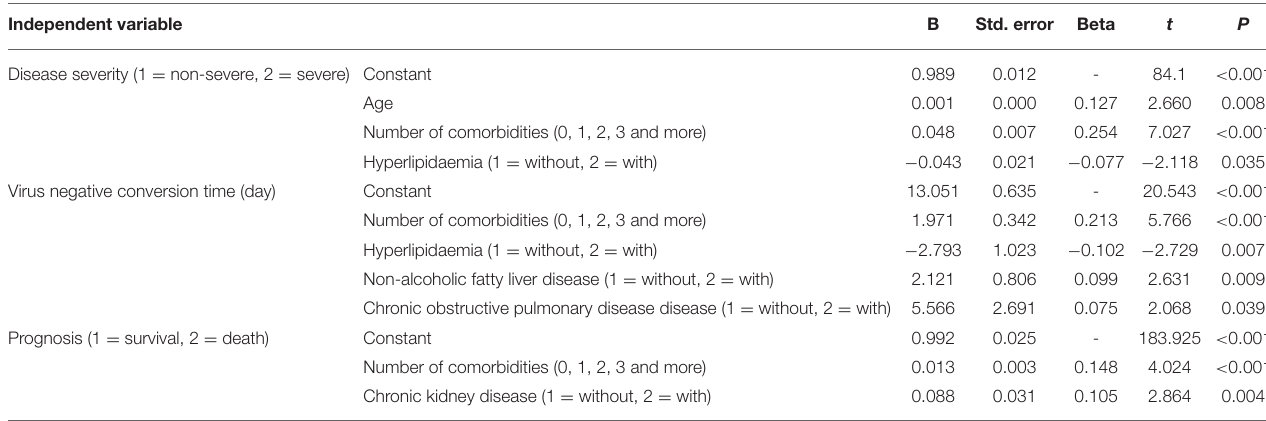
TABLE 7 | Multiple stepwise regression analysis of influencing factors for disease severity, clinical classification, coronavirus negative conversion time and prognosis ( n = 718). Independent variable